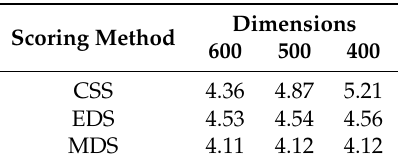
Table 4. The EER comparison of speaker verification system in different extracted dimensions of EVA-based